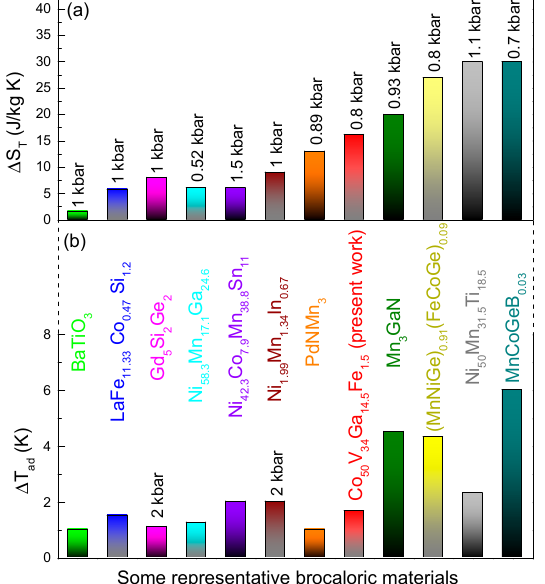
Figure 6. ( a ): The maximum isothermal entropy ( ∆ S T ) and ( b ): adiabatic changes ( ∆ T ad ) produced applied a similar hydrostatic pressure for some ferromagnetic, antiferromagnetic, paramagnetic, and ferroelectric barrocaloric materials. Data are extracted from [4–6,8,9,11,13–15,34,35].